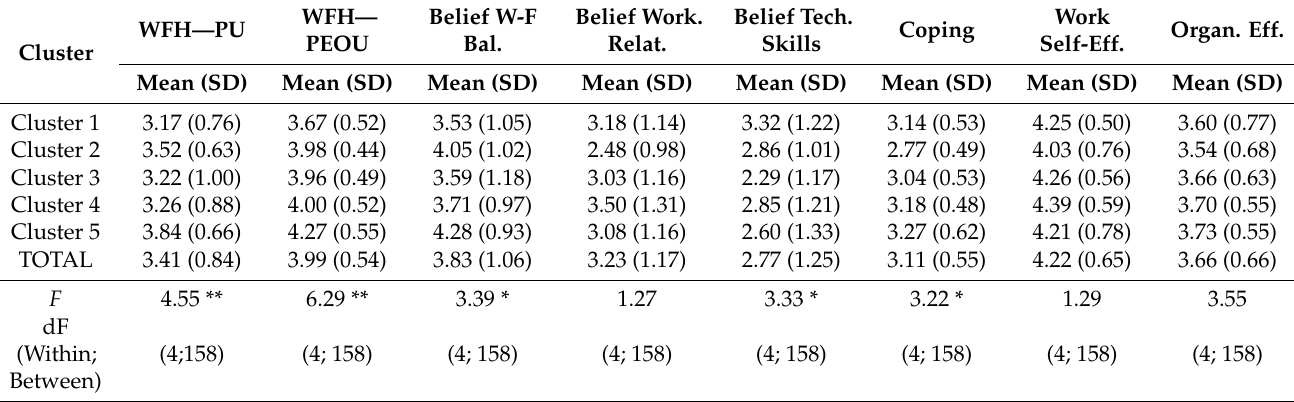
Table 6. Clusters, WFH acceptance, remote work attitudes, coping strategy, work self-efficacy and organizational effectiveness.